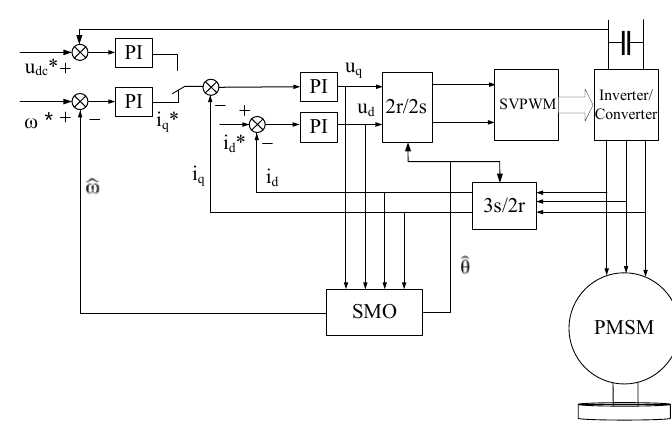
Fig. 15. FESS charging and discharging control block diagram based on SMO. Extended Kalman filter (EFK) uses statistical principle to estimate rotor position and angular velocity. EFK algorithm has strong suppression ability to system noise and measurement noise. At the same time, it also has good robustness to motor parameters. EFK algorithm is a recursive algorithm, which is divided into prediction stage and correction stage [43-46]